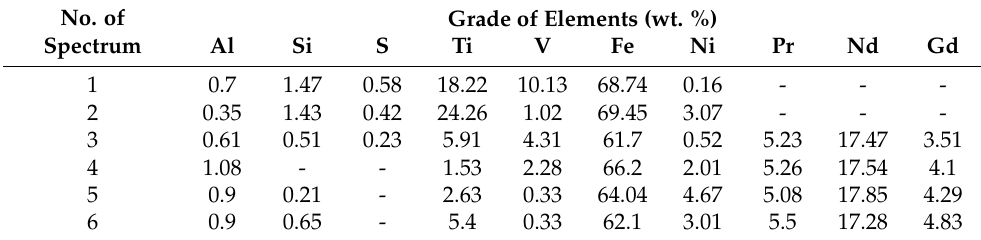
Table 4. Results on extraction of metals from magnetic fraction. Metal